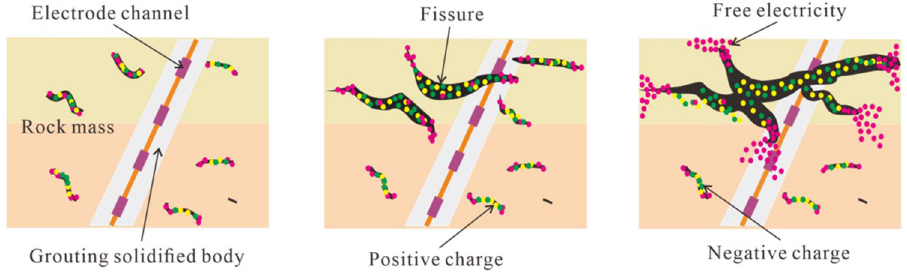
Figure 2. Schematic diagram of the monitoring of the geoelectric field of the rock mass fracture 25 .